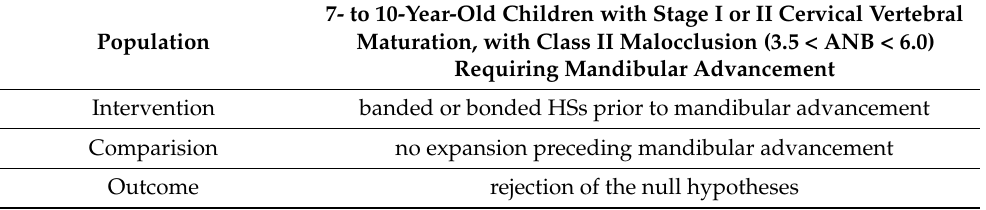
Table 1. PICO format.